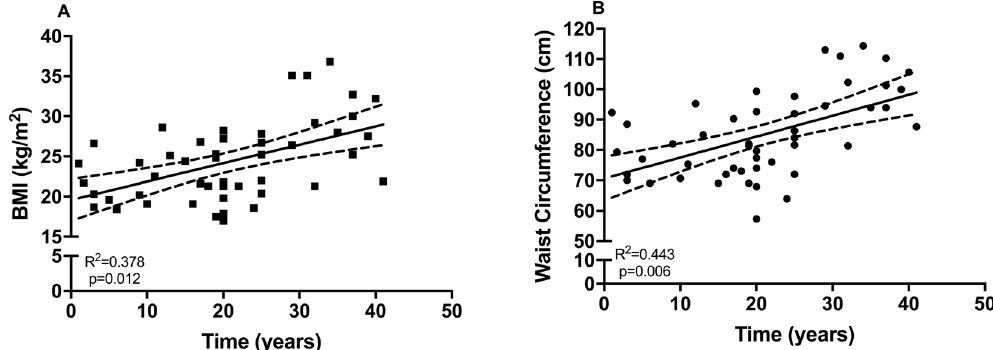
Figure 1. The association between length of stay in urban area with adiposity. The association between length of time in urban area with ( A ) body mass index (BMI) and ( B ) waist circumference are presented in scatter plot graphs (n = 49), and analysed using age-adjusted linear regression. The dotted line represents 95% confidence intervals. Each year increase of a time spent in urban area was associated with a significant increase in both (a) BMI [0.152 (0.036–0.269) kg/m 2 , p = 0.012] and (b) Waist Circumference [0.449 (0.135–0.762) cm, p =